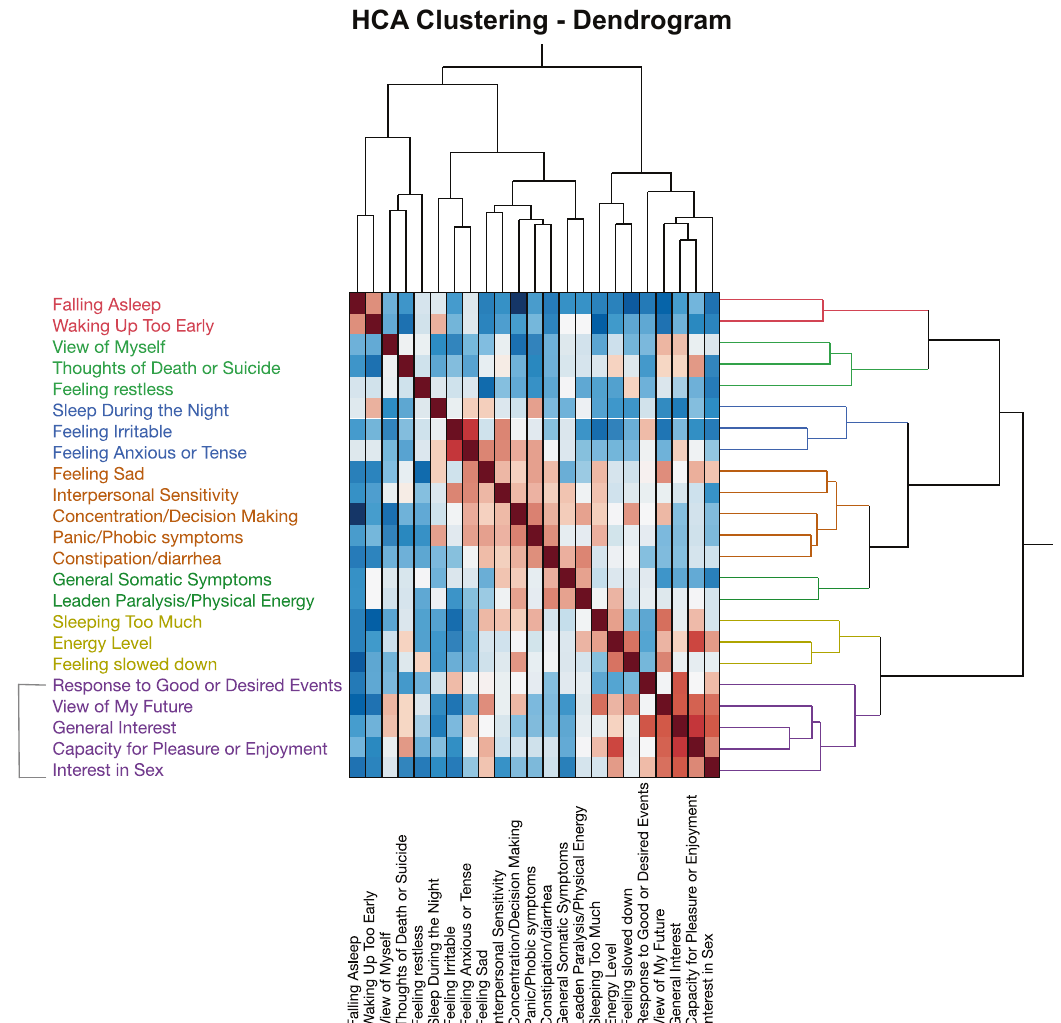
Fig. 3 Anhedonia – HCA clustering. The fi gure depicts the dendrogram from hierarchical clustering of individual items on Inventory for Depressive Symptoms-Self Rated Version (IDS-SR). After removing items with ambiguous and unreliable scoring on IDS-SR (details in text), the remaining 23 items were clustered using hierarchical clustering with Ward ’ s agglomerative method. As noted, anhedonia items on IDS-SR (items #8, 17, 18, 19, and 22) clustered tightly together and were combined into an “ Anhedonia ” factor. Item #18: Capacity for Pleasure or Enjoyment was removed during redundancy analysis, as it failed to load adequately onto its latent